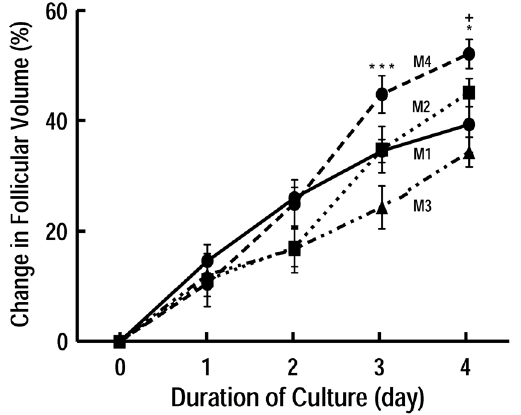
Figure 2. Effect of different culture system on preantral follicular development in vitro. Mouse preantral follicles (100– 130 m m in diameter) were isolated mechanically and cultured in different systems. M1 group was developed in culture dishes (35 mm) with 2 ml medium. In the second group (Method 2, M2), medium was made into 10 6 20 m l culture droplet, and covered with 3 ml of washed mineral oil. Follicles were placed in the culture droplets, 10 follicles per droplet. Two other groups were cultured in 4-well (Method 3, M3) and 96-well tissue culture plates (Method 4, M4) respectively. Follicular diameter was measured daily and results were expressed as change in follicular volume. Note that follicles grew faster in M4 group than M1 and M3 groups although the statistic analysis was not significant among others groups. + P , 0.05 vs. M1 at the same culture duration, *P , 0.05, ***P , 0.001, vs. M3 at the same culture duration.